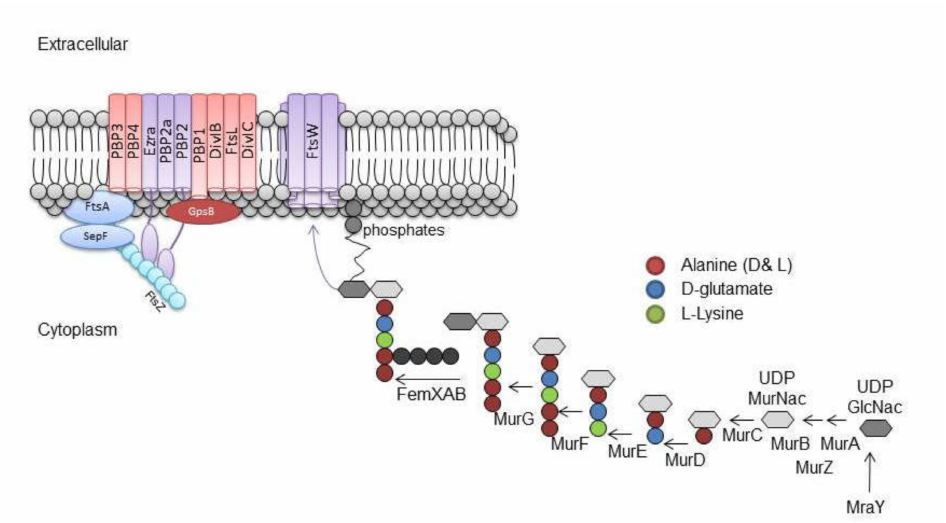
Figure 3. Proteins of the divisome recruited to the division septum of methicillin-resistant Staphylococcus aureus (MRSA) during cell division. Cytoplasmic synthesis of lipid II, the peptidoglycan precursor polymerised by penicillin-binding proteins (PBPs), is also shown in the not-to-scale representation. (Figure kindly provided by Dr. Sarah Paulin; from her PhD thesis